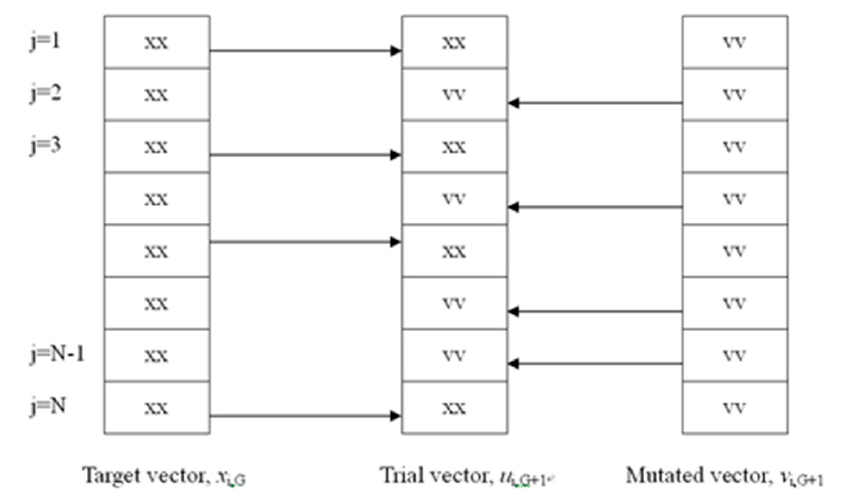
Figure 3. Binary crossover operator [15].